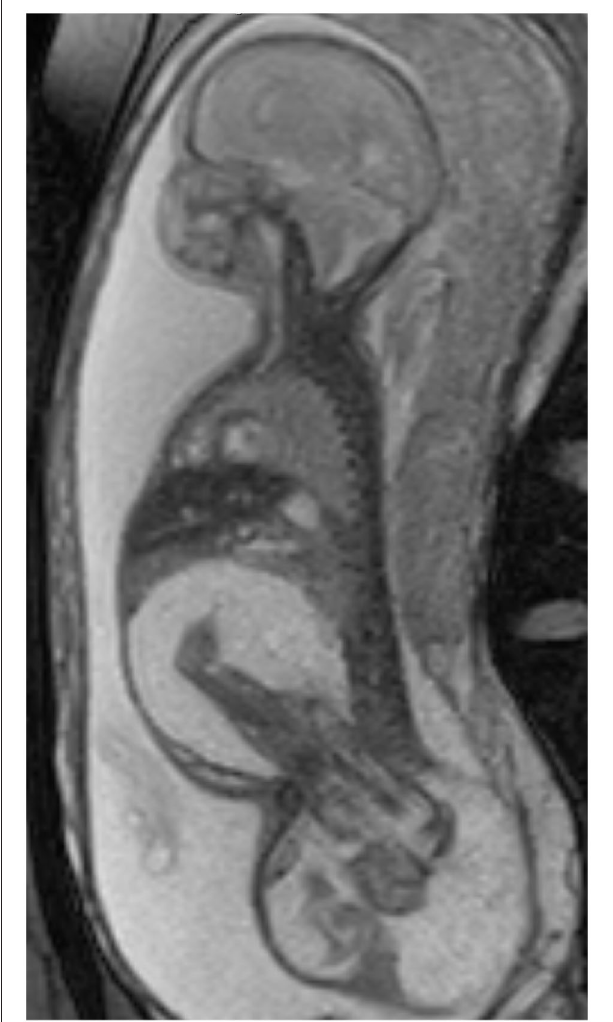
FIGURE 1 | Oblique sagittal T2 weighted fetal MR images demonstrate the large FIF spanning the host twin perineum, with markedly edematous legs of the parasitic twin within the abdominal cavity of the